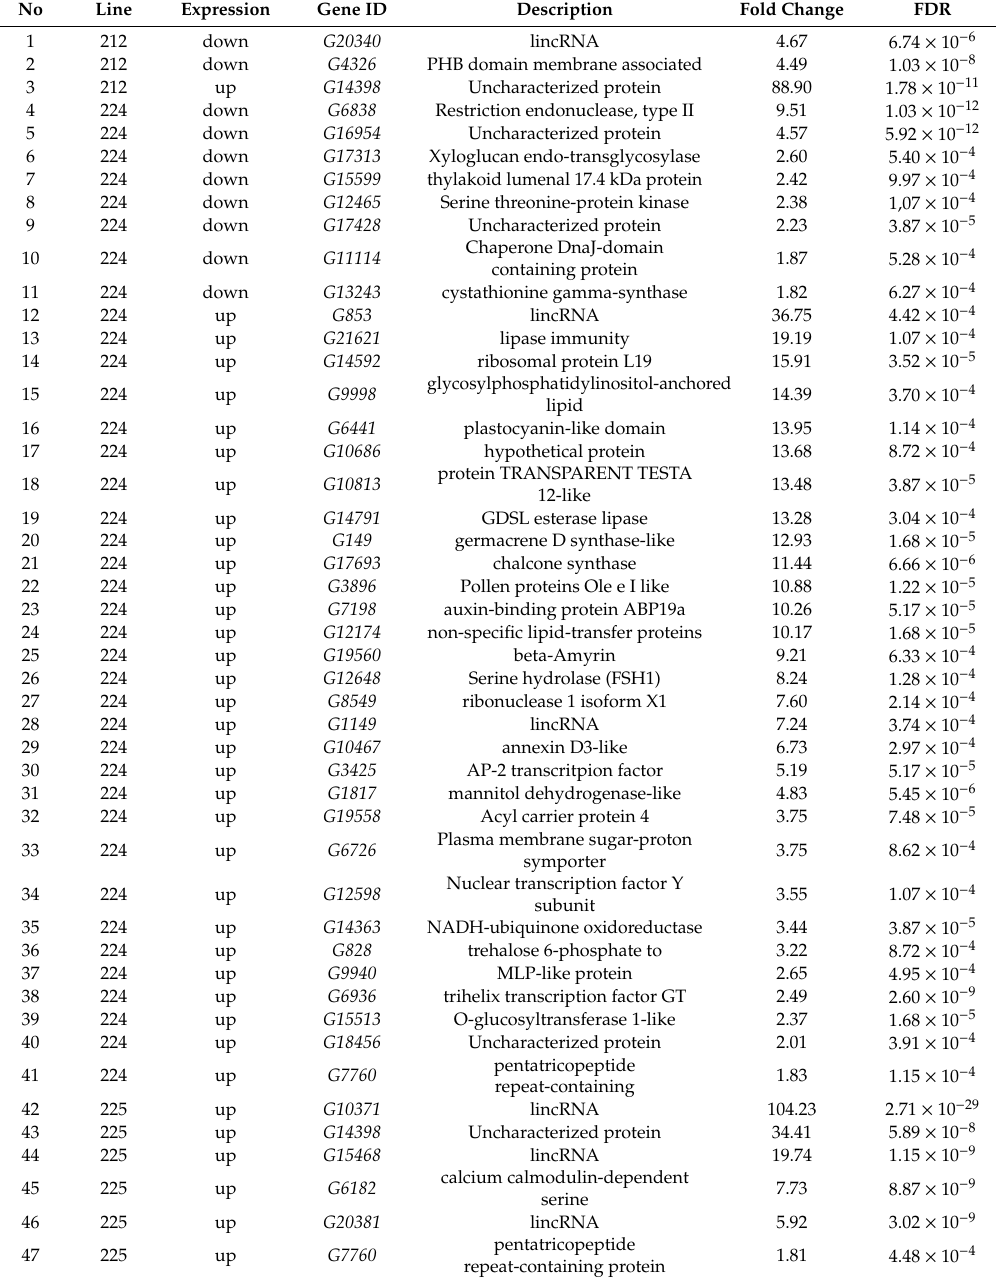
Table 1. Di ff erentially expressed genes (DEGs) in transgenic lines (212, 224, and 225) versus the wild-type B10